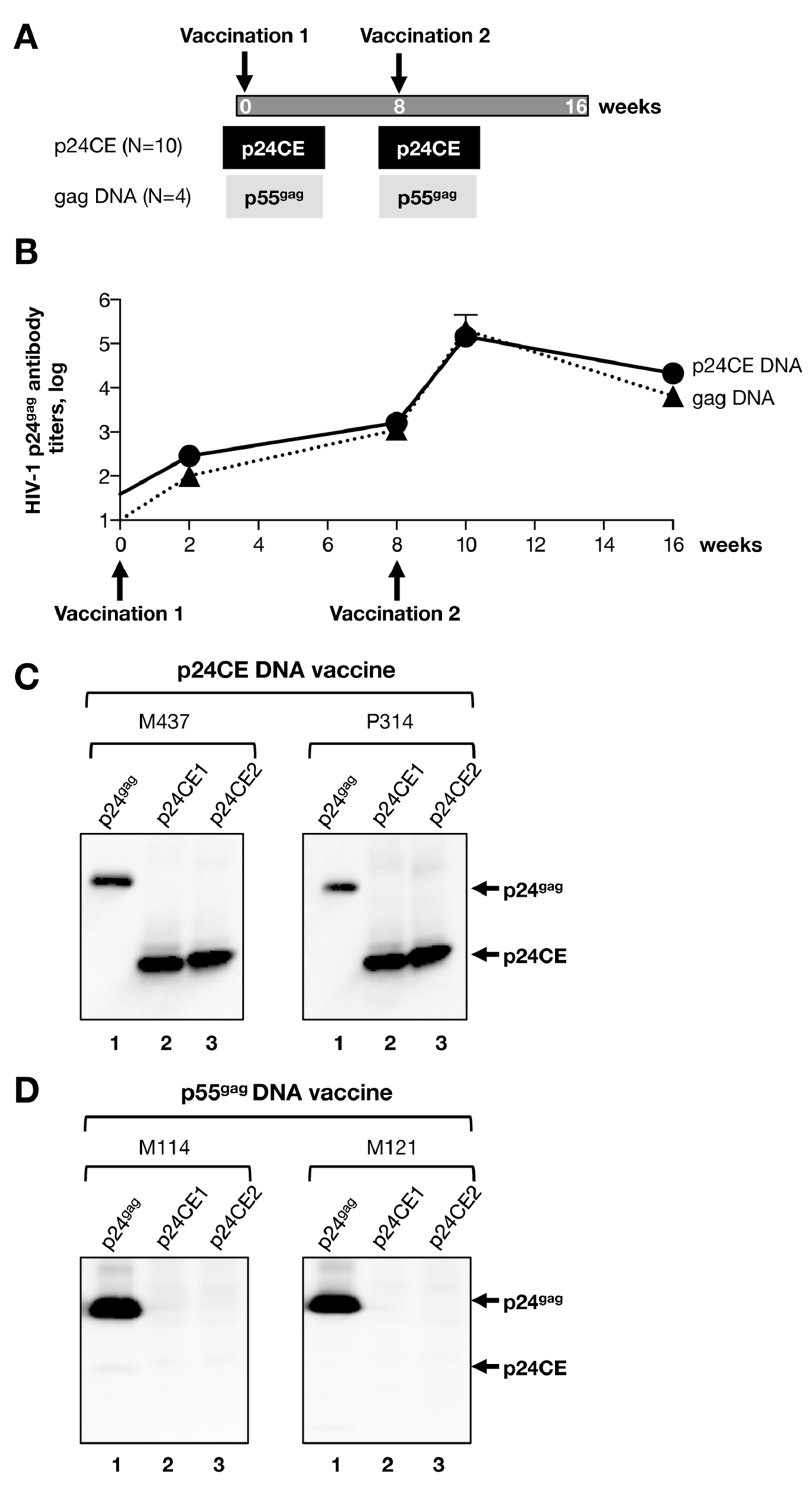
Figure 2. Induction of humoral immune responses upon p24CE DNA vaccination in macaques. (A) Cartoon depicts the vaccination schedule. Each macaque received 2 vaccinations with a mixture of p24CE1 and p24CE2 DNAs or p55 gag DNA at week 0 and 8. Plasma samples were analyzed for bAb to Gag at the time of each vaccination and at the additional indicated time points. (B) Plasma bAb to HIV-1 p24 Gag measured by ELISA. Mean and standard error of the reciprocal Gag antibody endpoint titers (in log 10 ) of 10 macaques vaccinated with p24CE DNA mixture and 4 macaques which received the p55 gag DNA are shown. ( C, D ) Western immunoblot analysis was used to identify binding antibodies to HIV-1 p24 Gag and the p24CE proteins present in plasma collected after the last vaccination. The membranes contain the soluble processed clade B p24 gag protein (lane 1), p24CE1 (lane 2) and p24CE2 (lane 3) protein and were probed with plasma collected after the last vaccination. The data from 2 representative macaques from each vaccine group are shown: (C) p24CE DNA vaccinated animals M437 (plasma dilution 1:2000) and P314 (plasma dilution 1:1000) and (D) p55 gag DNA vaccinated animals M114 and M121 (plasma dilution 1:2000 for both). The positions of p24 gag and p24CE proteins are indicated. doi:10.1371/journal.pone.0111085.g002 PLOS ONE |